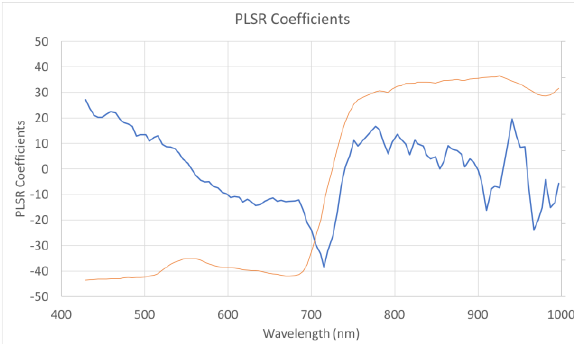
Figure 11 . PLSR coefficients using DESIS reflectances applied to midday GPP from flux towers. Blue line shows the coefficient values, orange line is a representative reflectance spectra (not scaled to y-axis) for